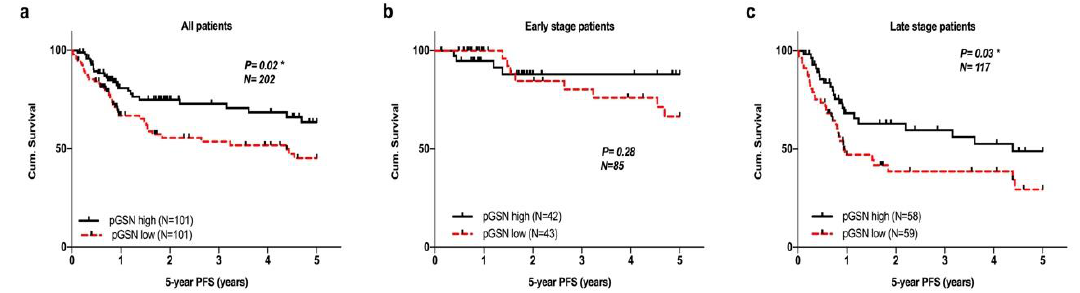
Figure 5. Five-year progression-free survival (PFS) of patients with HNC stratified by the median of circulating pGSN. ( a ) Kaplan–Meier survival analysis stratified by circulating levels of pGSN in the entire HNC population ( n = 202) revealed that patients with higher circulating pGSN levels demonstrated enhanced 5-year PFS than did those with lower pGSN levels ( p = 0.02). ( b ) pGSN levels failed to present a significant influence on 5-year PFS of early-stage patients. ( c ) For patients at late HNC stage ( n = 117), pGSN presented significant predictive value for the 5-year PFS in patients with HNC ( p = 0.03). The p values were calculated using the log-rank test.